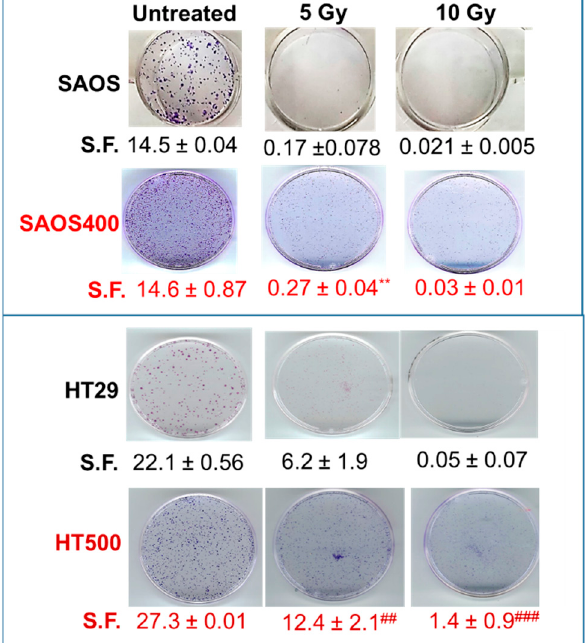
Figure 3. Colony-forming assay. Representative images are reported comparing SAOS and HT29 cells with their respective radio-resistant counterparts, SAOS400 and HT500 cells. Numbers below each row of panels indicate the means of counted colonies ± SD expressed as S.F (Surviving Fractions) from two independent experiments. Symbols indicate significance with ** p < 0.01 with respect to SAOS cells and ## p < 0.01 and ### p < 0.001 with respect to HT29 cells (Student’s t-test).